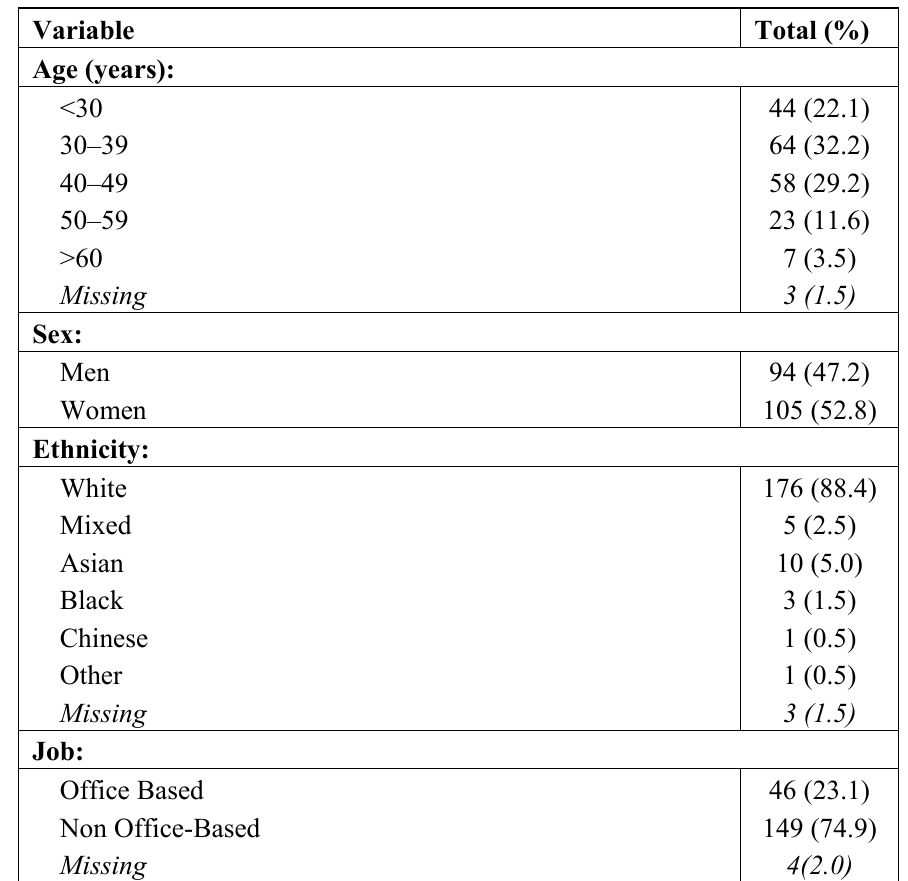
Table 1. Characteristics of